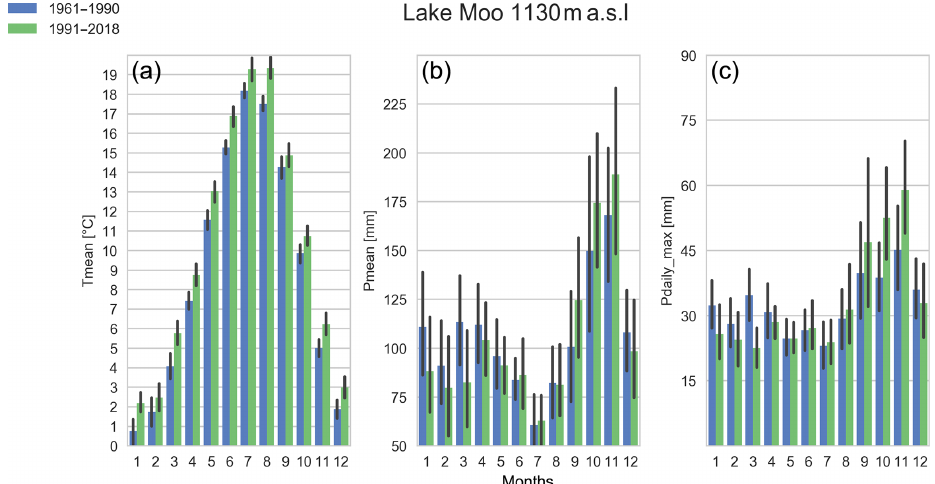
Figure 9. Monthly mean 2m temperature (a) , accumulated precipitation (b) and maximum daily precipitation (c) for 1961–1990 (blue) and 1991–2018 (green) computed over the Lake Moo site grid cell of the Eraclito reanalysis (grid cell 258, Ferriere Municipality). Confidence intervals at 95% significance (black vertical segments) are computed with a bootstrapping method (1000 iterations) as part of the Seaborn Python library.